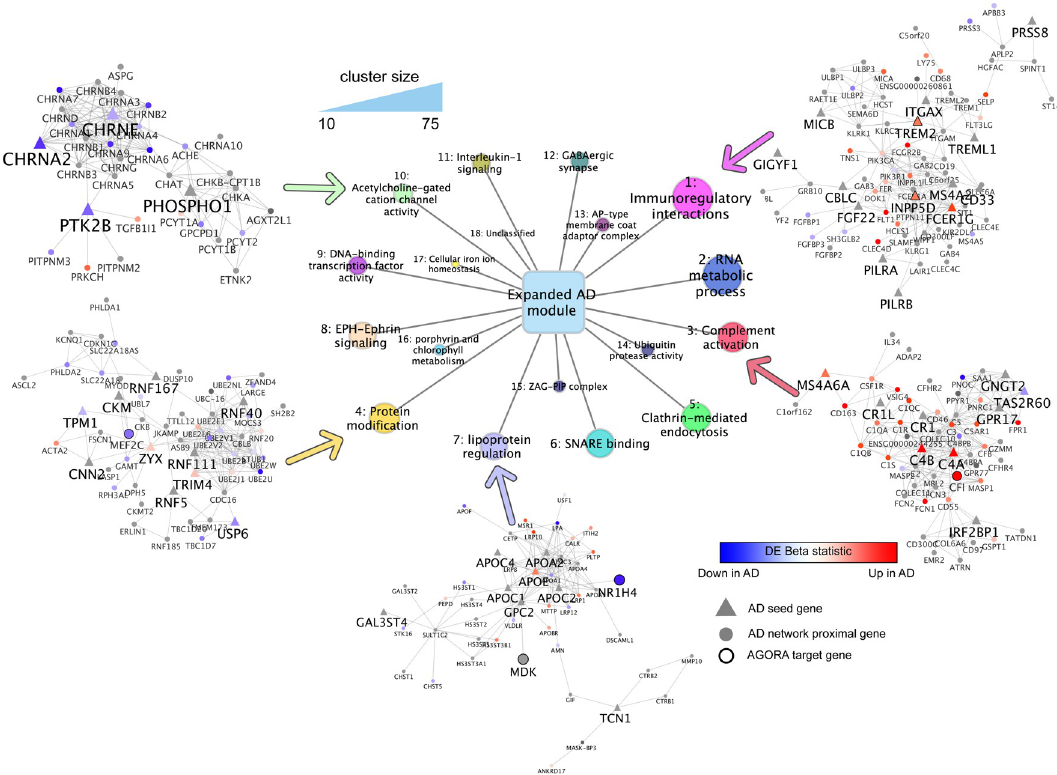
Fig 2. Expanded AD disease module and highlighted distinctive clusters annotating different biological pathways possibly involved in AD. Clusters identified in the expanded AD module labeled in the center. Genes comprising 5 selected clusters are depicted around the edges of the figure. The temporal cortex RNAseq beta statistic is mapped to the gene color, and shape indicates AD GWAS seed gene (triangle) or network proximal gene (z > 2, circle). Bold black outlines indicate AGORA proposed drug targets (e.g. CHRNA2, PTK2B). Seed genes or genes with AGORA targets are labeled with a larger font, while other genes identified by network propagation are labeled with a smaller